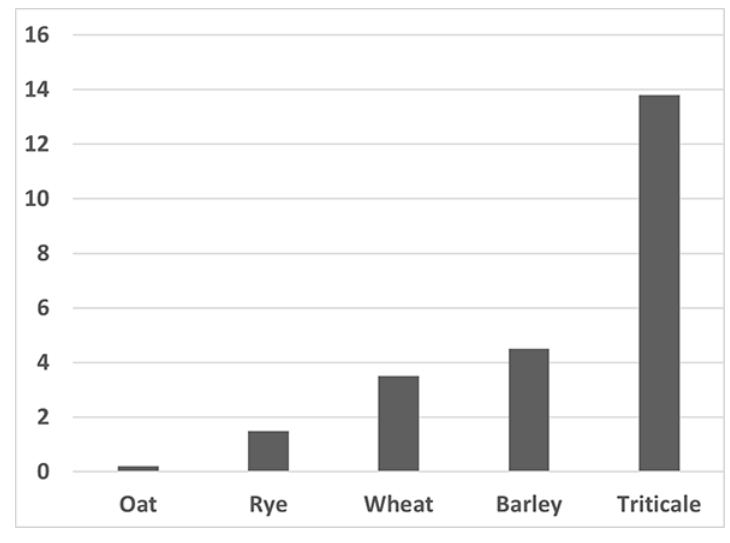
Figure 4 Regeneration effectiveness (number of green regenerants per 100 anthers cultured) of various cereals. Anthers were collected from 23 to 30 lines from each species, and from at least 20 spikes per